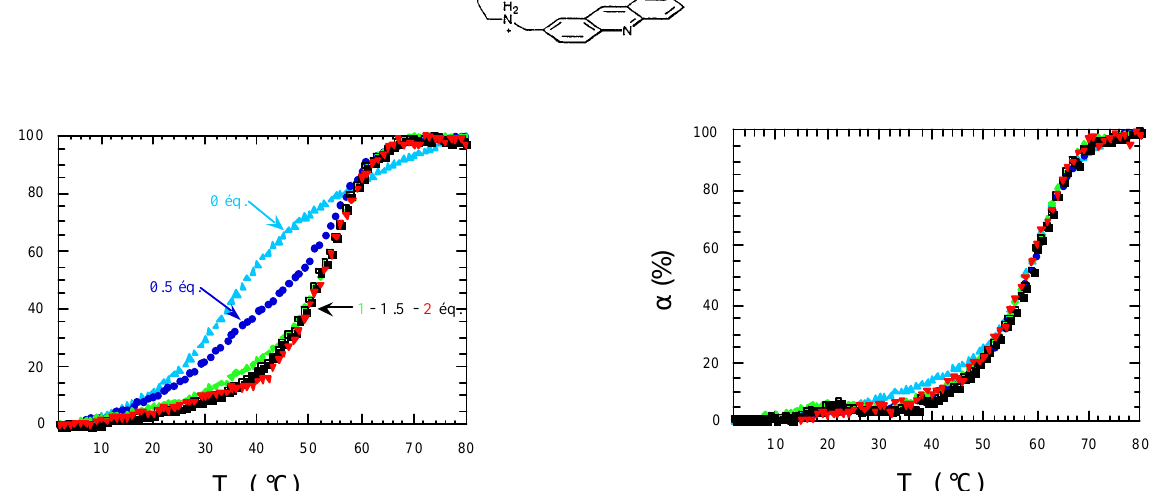
Figure 11. Recognition of abasic sites in DNA by cyclobisacridine 1 : MT experiments. e) EPR